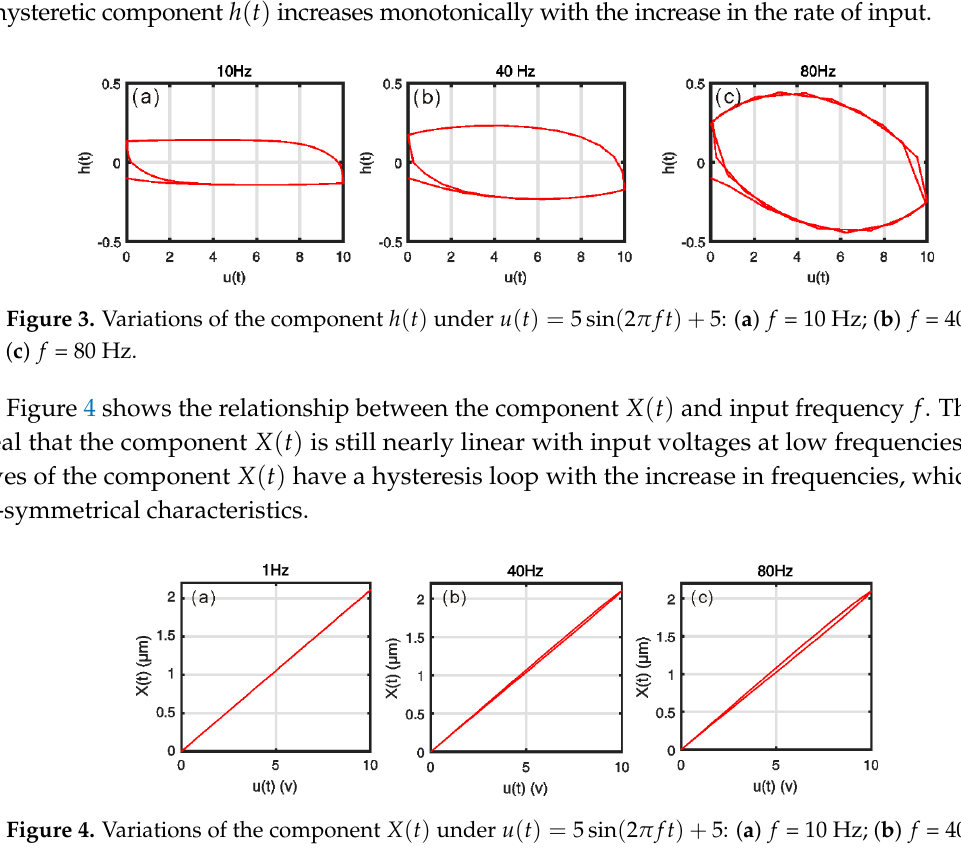
Figure 4. Variations of the component ( ) X t under ( ) 5sin(2 ) 5 u t ft π= + : ( a ) f = 10 Hz; ( b ) f = 40 Hz; ( c ) f = 80 Hz.